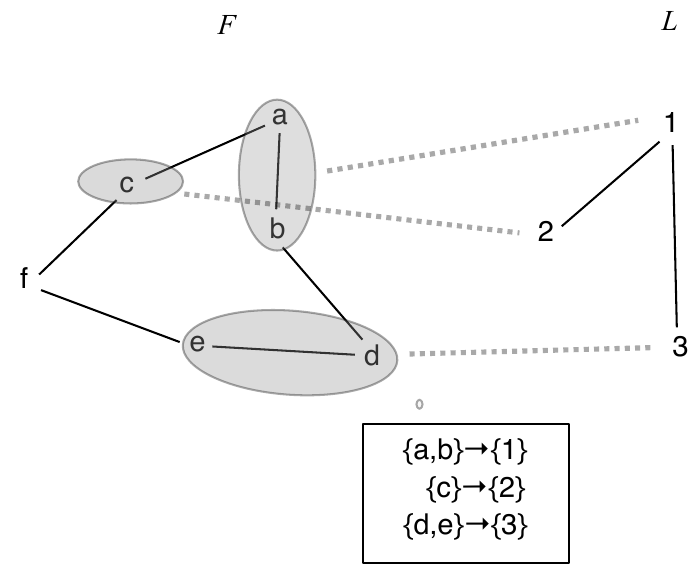
Figure 2: Example of an isomorphic embedding of schemas (sets of feature values) and labels. closest to the set λ (cid:48) and record this (minimal) distance; then calculate the minimal point-to-set distance from λ (cid:48) to λ . The Hausdorff distance between the sets is the maximum of the two minimal point-to-set distances.